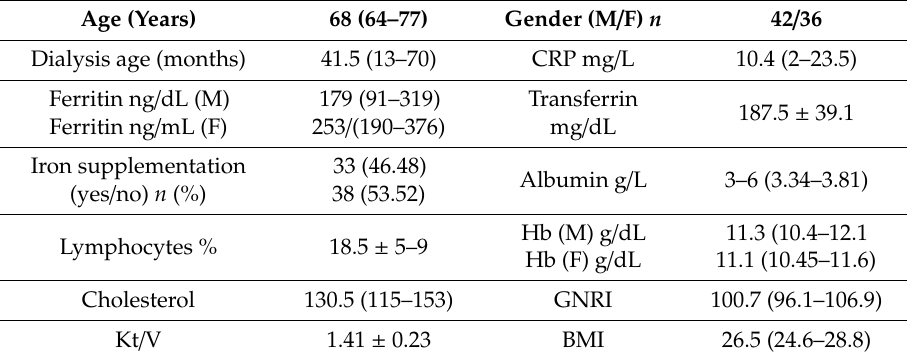
Table 1. Demographic and laboratory characteristics of 78 end-stage renal disease (ESRD) patients.